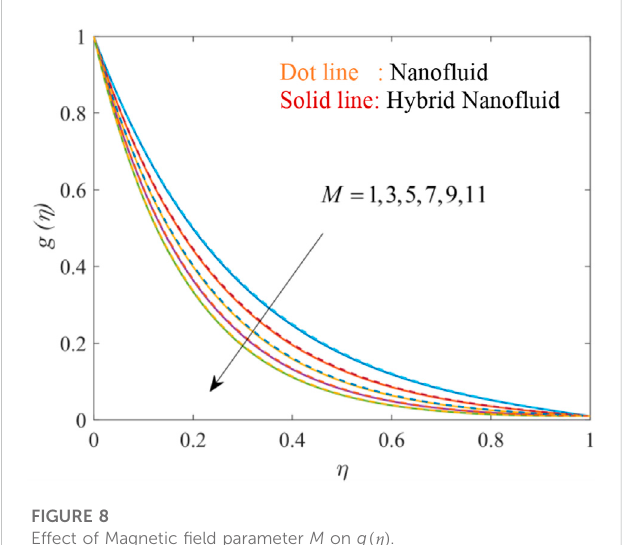
FIGURE 10 Effect of nanoparticles volume fraction φ on f ′ ( η )